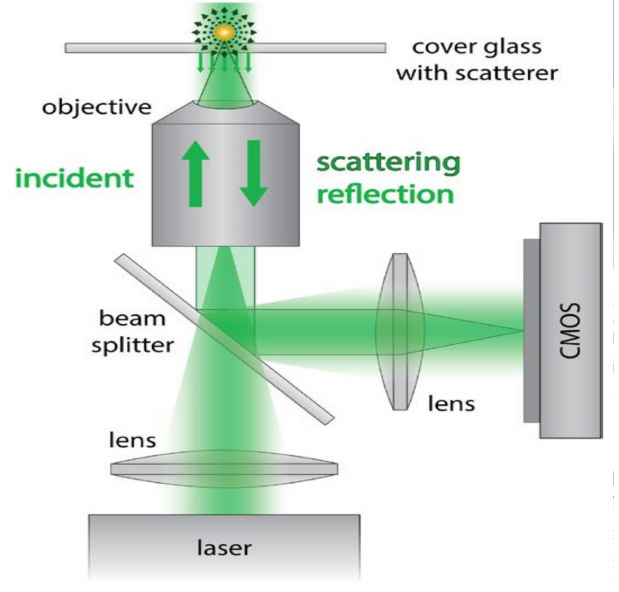
Figure 6. Schematic of the Interferometric scattering microscopy. Laser light is focused on the back focal plane of the high numeral aperture microscope objective. The reference and scattered light from the sample are reflected by a beam splitter and captured by a CMOS camera. Reproduced with permission from reference [163]. Copyright (2016) IOP